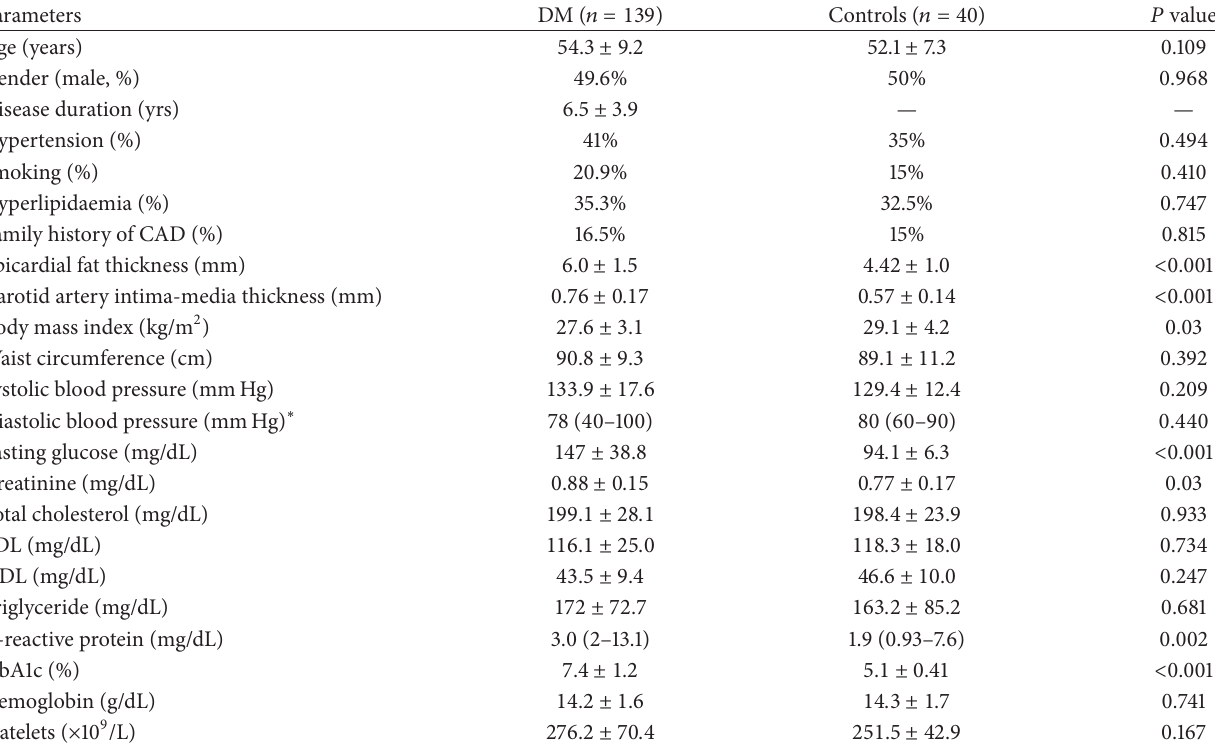
Table 1: Clinical and biochemical characteristics of the patients with type 2 diabetic patients and healthy controls.